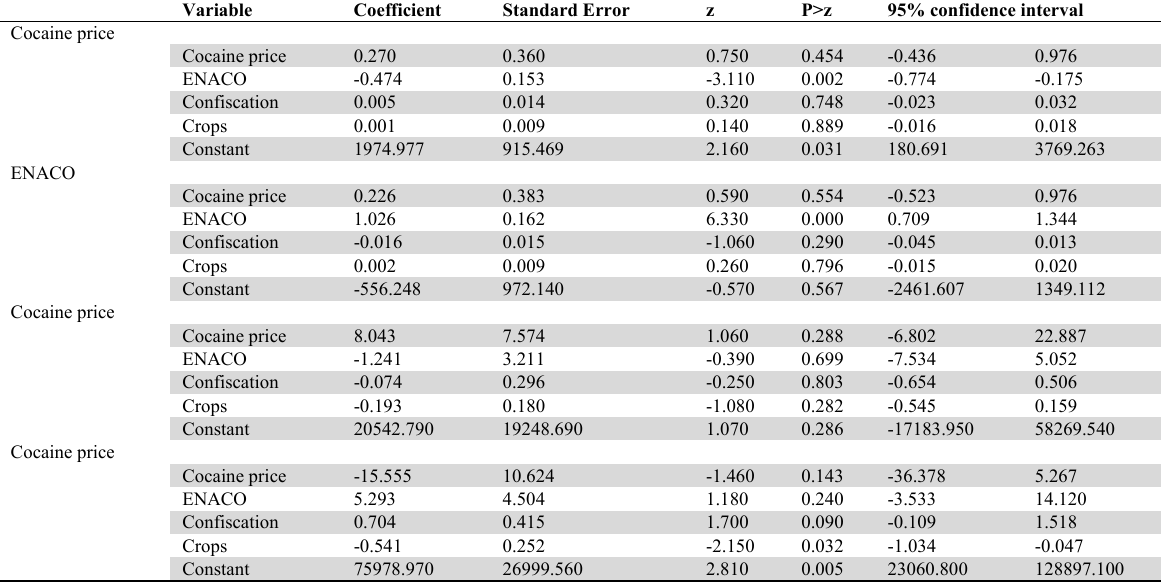
Stationary test